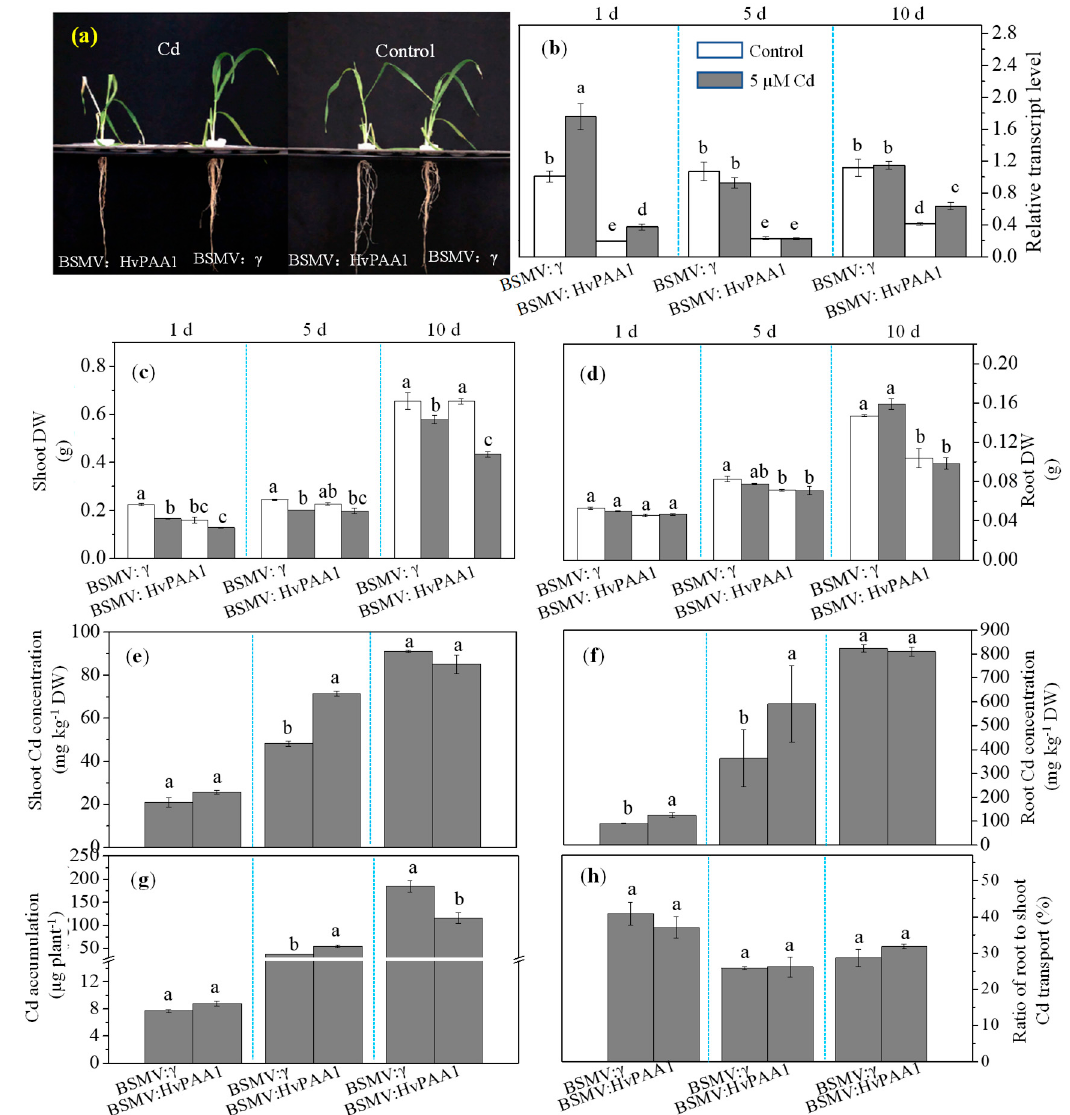
Figure 6. Functional assessment of HvPAA1 in Zhenong 8 using BSMV-VIGS (barley stripe mosaic virus- virus induced gene silencing). ( a ) Morphology of mock- or BSMV: HvPAA1-inoculated Zhenong 8 seedlings after 10 days of exposure to 5 µ M Cd. Scale bars = 6 cm. ( b ) RT-PCR analysis of the relative transcript levels of HvPAA1 in Zhenong 8 leaves. Different letters indicate significant differences among the treatments within 3 sampling data (1, 5, 10 d after the initiation of Cd stress) according to Duncan’s multiple range test with p < 0.05. ( c , d ) Dry weights of mock- and BSMV:HvPAA1-inoculated Zhenong 8 plants. ( e , f ) Cd concentrations of mock- and BSMV:HvPAA1-inoculated Zhenong 8 plants grown in 5 µ M Cd. ( g ) Cd accumulation in mock- and BSMV:HvPAA1-inoculated Zhenong 8 plants grown in 5 µ M Cd. ( h ) root-to-shoot Cd transport ratio. Error bars represent the SE values. Different letters indicate significant differences between control and Cd treatment, between each sampling date, and between the mock- and BSMV:HvPAA1 inoculated seedlings according to Duncan’s multiple range tests with p < 0.05.